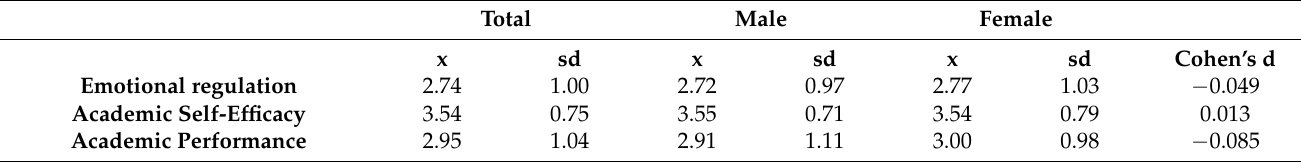
Table 2. Results of descriptive variables emotional regulation, self-efficacy and academic performance.